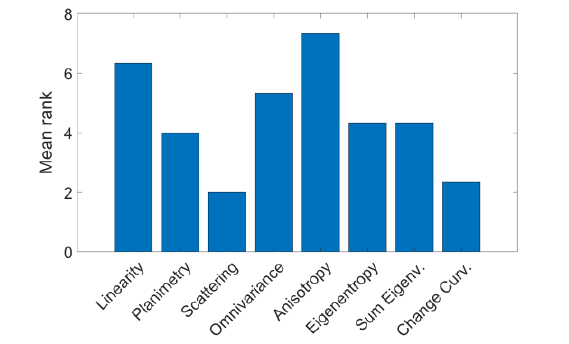
Figure 6. Mean rank of the eight eigenfeatures